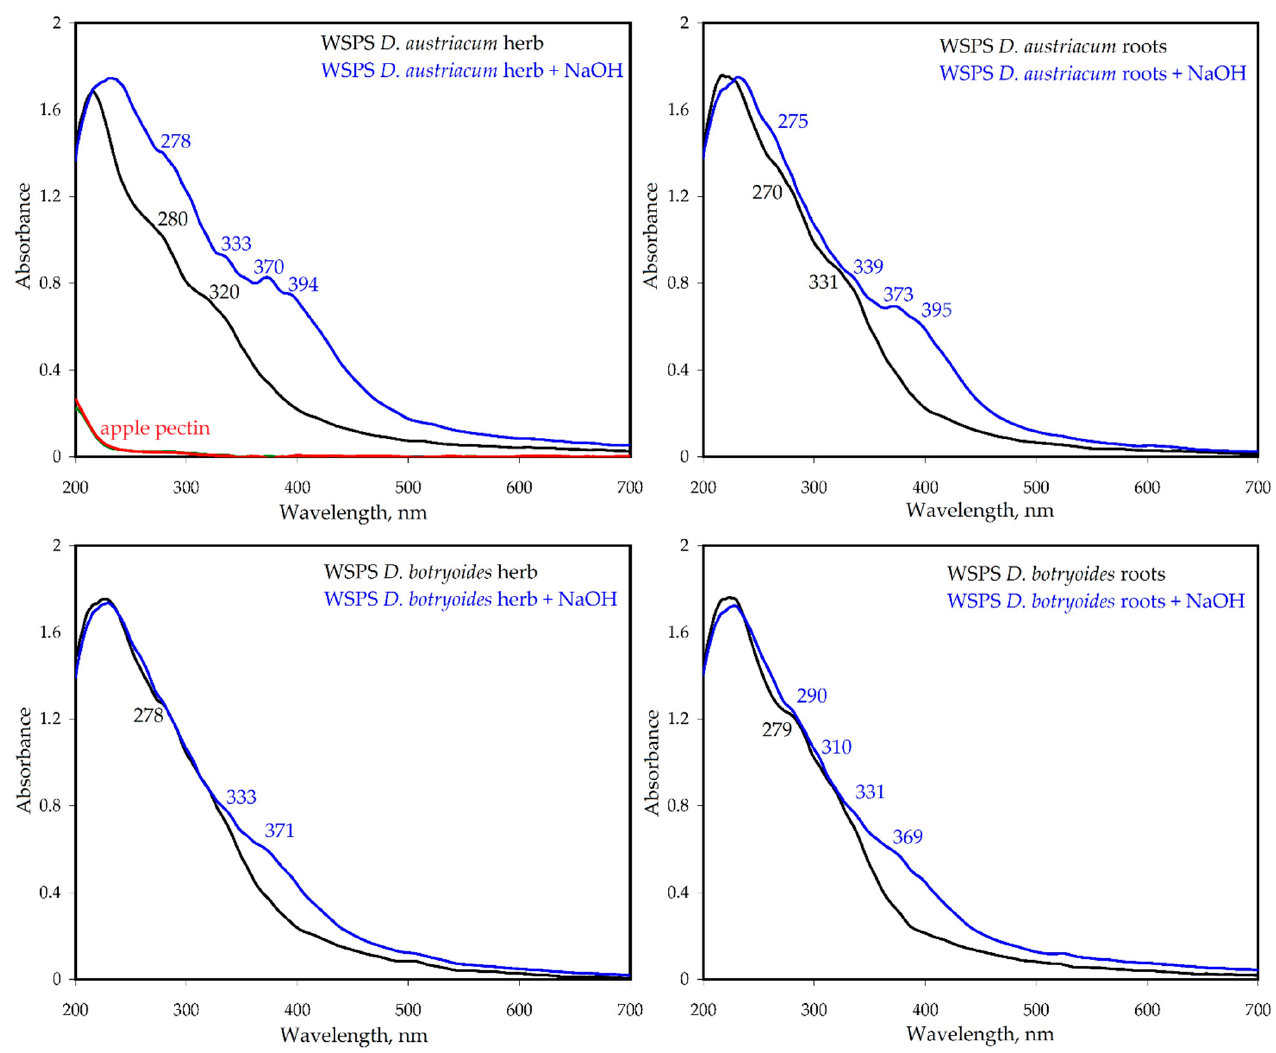
Figure 5. UV-Vis spectra of water-soluble polysaccharides of herbs and roots of D. austriacum and D. botryoides .